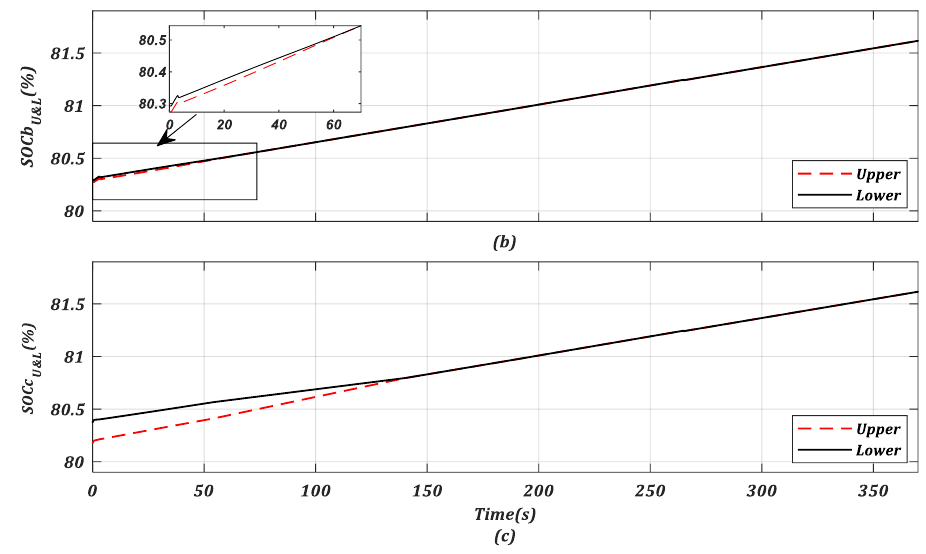
Figure 9. Average upper and lower SOC of the converter arms: ( a ) in phase A, ( b ) in phase B; ( c ) in phase C.